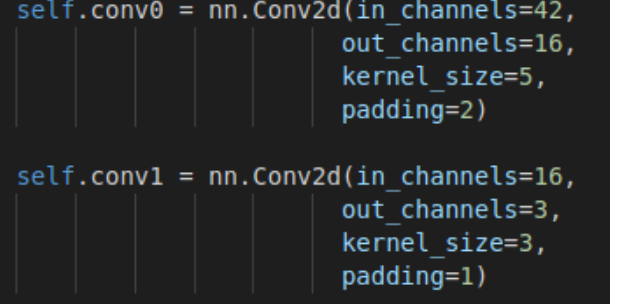
Figure A6. Convolution layers. Source: https://github.com/Keredu/Intracranial-Hemorrhage- Detection/blob/main/src/model.py, accessed on 16 November